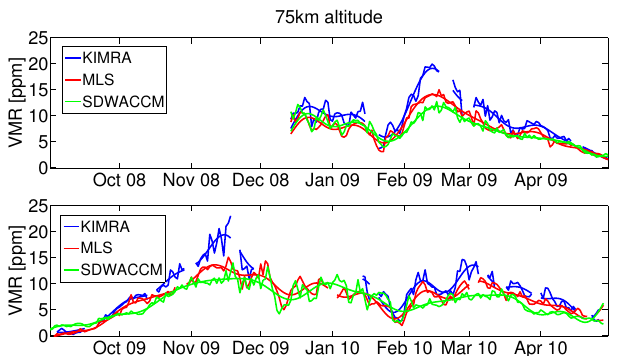
Fig. 5. Similar to Fig. 3, but for 75km altitude.